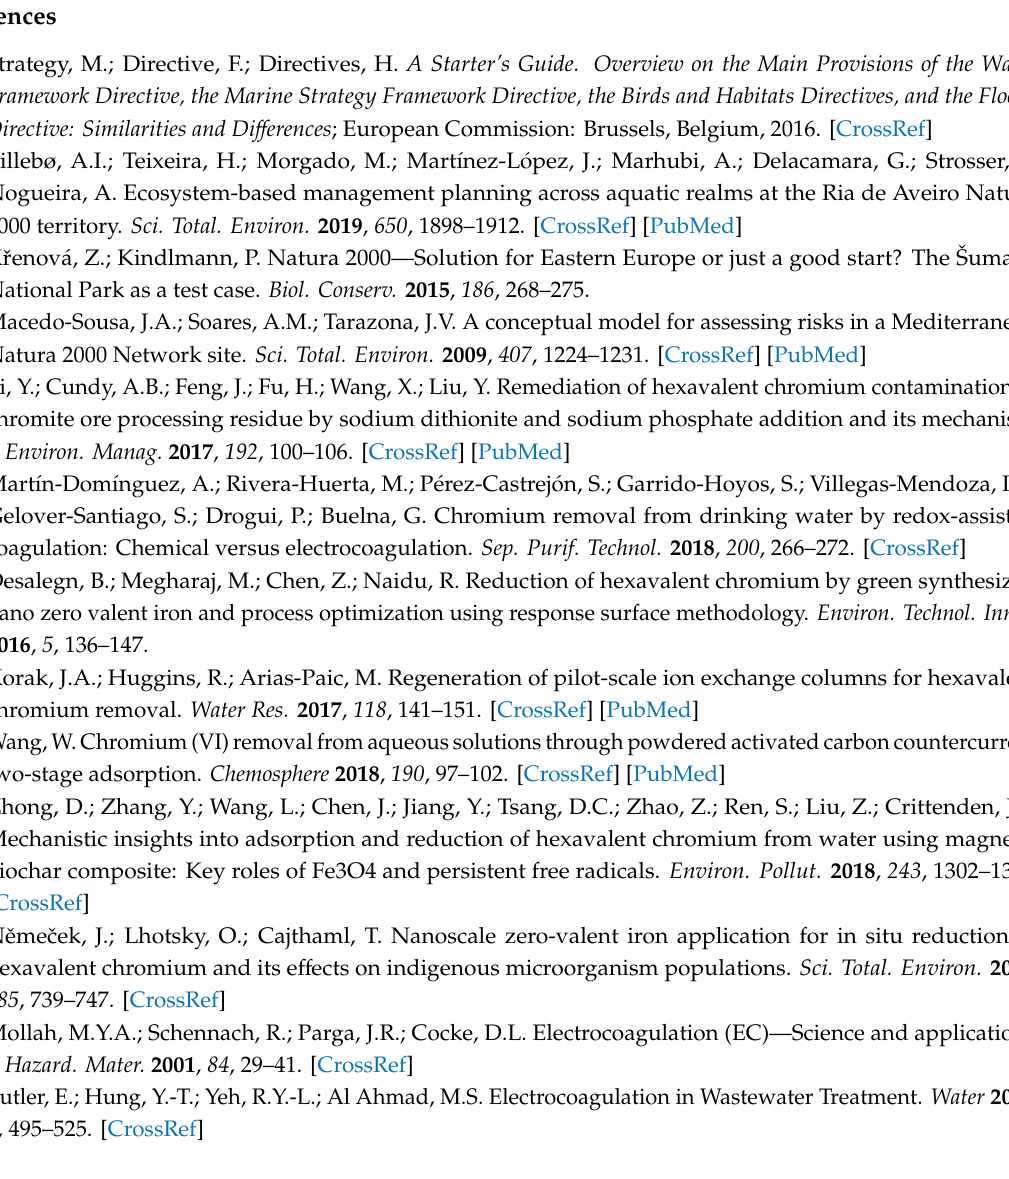
Figure S1: Detail of EC cell: Upper—Outer jacket of the cell; Lower—Electrode pack with top cap. Figure S2: Placement of the container unit. Figure S3: Schematic drawings of EC chamber and mixing tanks arrangement inside the container. Figure S4: A borehole used for pumping of contaminated water. Figure S5: Filter-press with concentrated sludge. Figure S6: Long-term variation of Cr and Ni input concentrations. Figure S7: All three weeks data of residual concentrations of Fe, Cr, and Ni. Table S1: Protocol of sludge leachate analysis according to Czech regulation 294 / 2005 legal